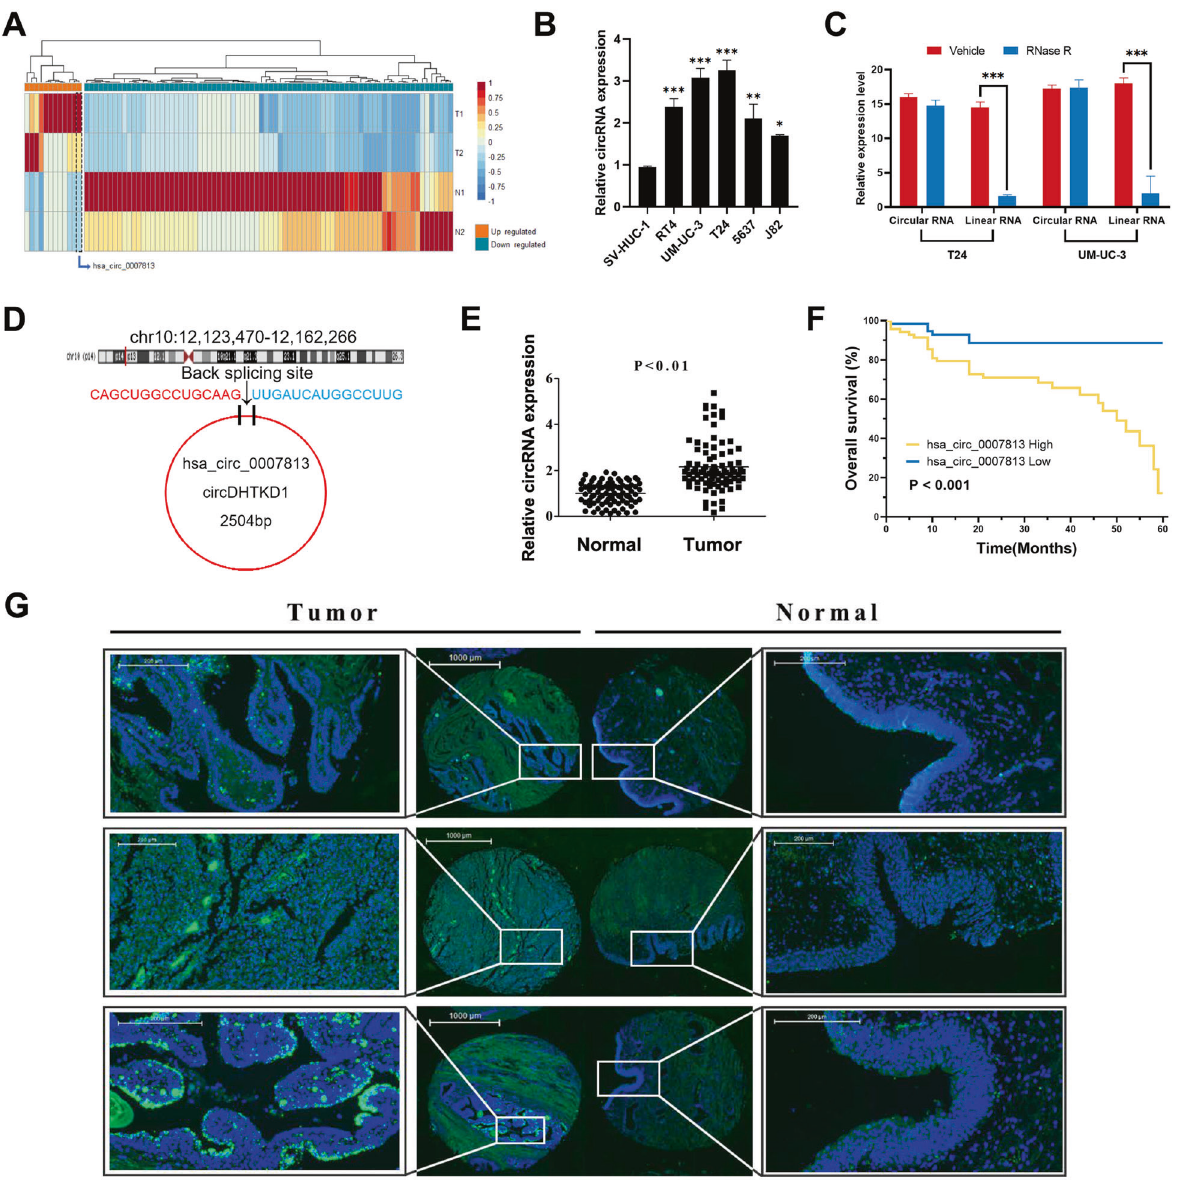
Fig. 1 High hsa_circ_0007813 expression predicted unfavorable prognosis in bladder cancer patients. A Heatmap illustrated expression patterns of differentially expressed circRNAs between two bladder cancer tissues (T1 and T2) and their paired adjacent normal tissues (N1 and N2). B Relative hsa_circ_0007813 expression was upregulated in fi ve bladder transitional cell carcinoma cell lines (RT4, UM-UC-3, T24, 5637, and J82), comparing with immortalized uroepithelium cell line SV-HUC-1 ( N = 3, Kruskal – Wallis test). C Total cell RNA from T24 and UM-UC-3 was treated with or without RNase R. Expression level of hsa_circ_0007813 and its linear form was measured by qRT-PCR ( N = 3, Kruskal – Wallis test). D Diagram of the back-splicing site of hsa_circ_0007813. E FISH for hsa_circ_0007813 in TMA showed that expression of hsa_circ_0007813 was higher in tumor tissues ( N = 90, Wilcoxon matched-pairs signed-rank test). F Kaplan – Meier survival plot for bladder cancer patients ’ overall survival, grouped by median hsa_circ_0007813 expression level ( N = 90, Logrank test). G Representative areas of FISH in TMA were selected to show hsa_circ_0007813 expression between paired tumor and normal samples (Green: hsa_circ_0007813, Blue: DAPI, scale bars represent 1000 μ m). All error bars in the fi gures indicated the standard deviation of three independent experiments. * P < 0.05, ** P < 0.01, *** P <